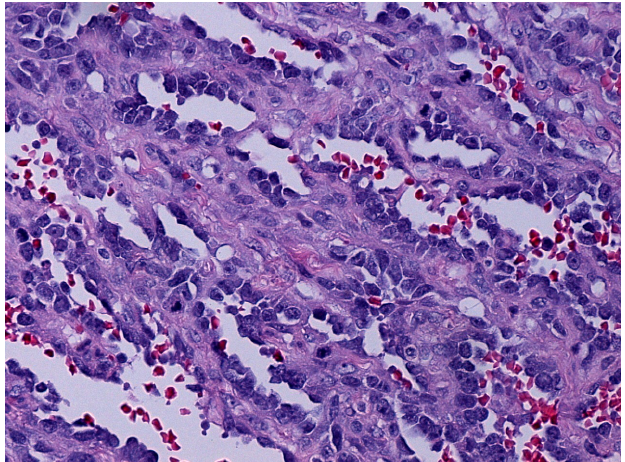
Figure 2: Microscopic examination showing high-grade spindle cells with enlarged atypical nuclei and plump endothelial cells lining large vascular spaces. There are a number of mitotic figures present.